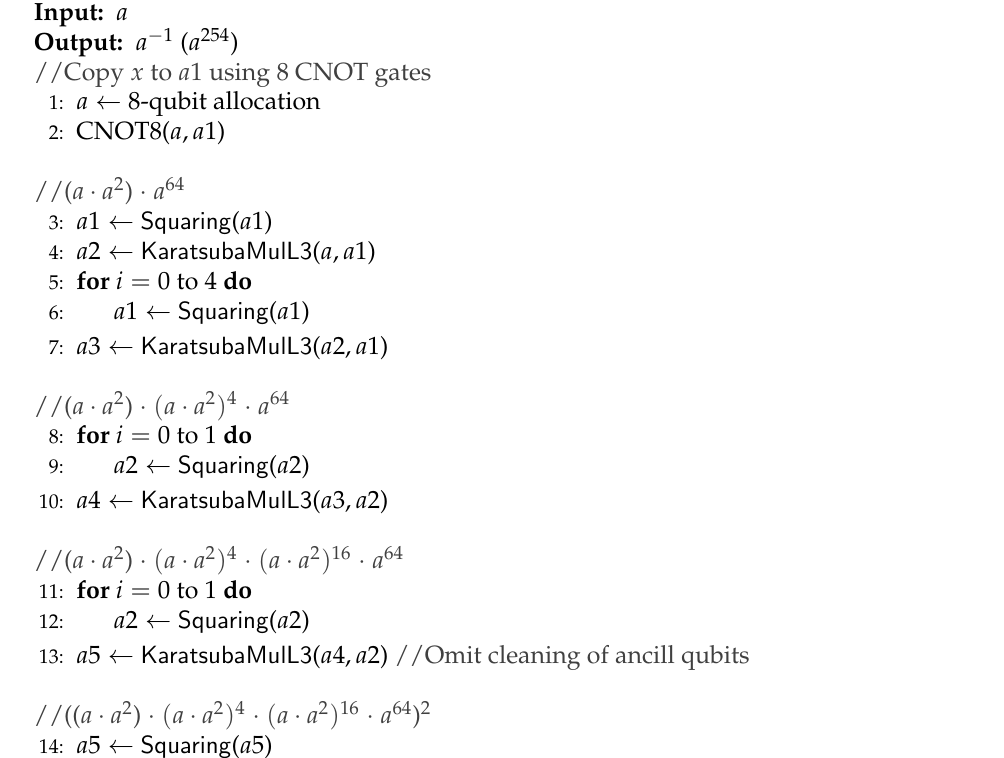
Algorithm 2 Quantum circuit for Inversion of F